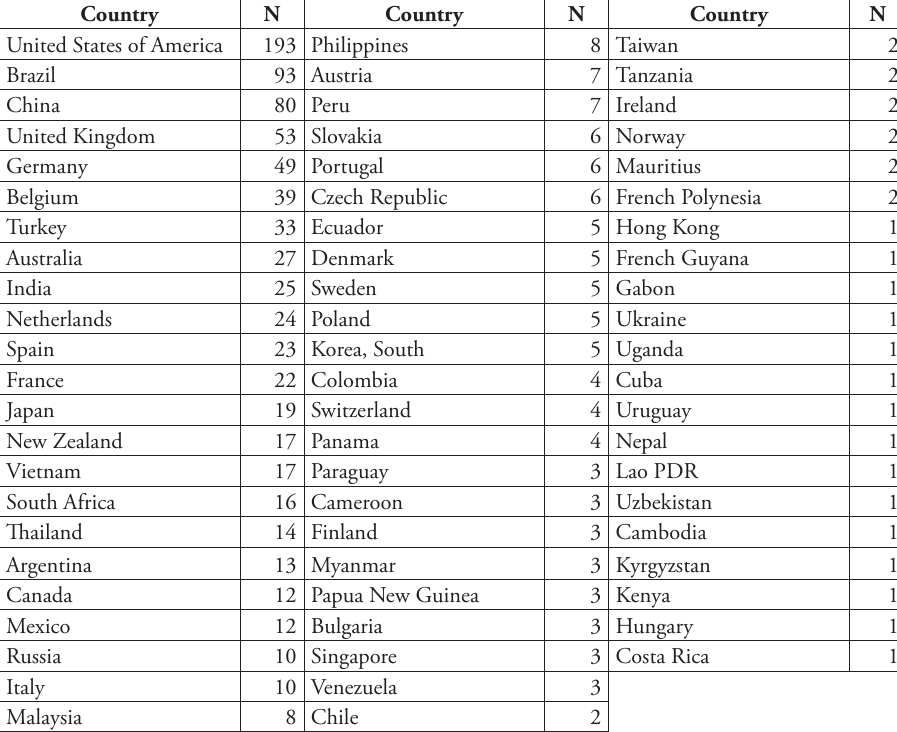
Table 2. Total number of PhytoKeys authors per